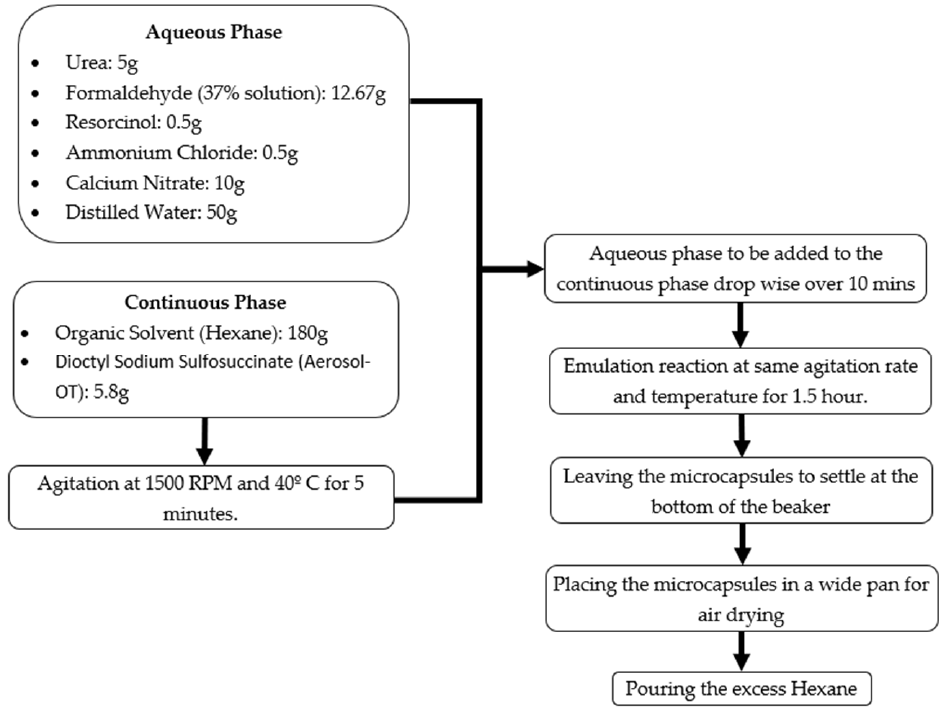
Figure 1. Microcapsule preparation method schematic illustration.